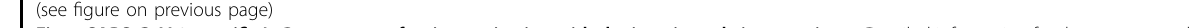
Fig. 1 SARS-CoV-2-speci fi c IgG responses after immunization with the inactivated virus vaccine. a Detailed information for the serum samples. b Sample collection after vaccination. Red dots represent volunteers who have four data points. c IgG pro fi les of vaccinated and convalescent sera against the SARS-CoV-2 proteome. FI, fl uorescence intensity, was shown in log scale, i.e., log 2 (FI) ranges from 0 to 14. d – m IgG responses to selected proteins. Antibody responses against SARS-CoV-2 proteins, the S protein ( d ), S1 subunit ( e ), RBD ( f ), N protein ( g ), N-Nter ( h ), N-Cter ( i ), NSP7 ( j ), NSP8 ( k ), NSP9 ( l ), and RdRp ( m ). Sera were collected from vaccinated volunteers at 21 and 28 days after the 2nd vaccine dose ( n = 27) and from convalescent patients ( n = 52). The P value was calculated by the two-sided Student ’ s t -test. * P < 0.05, ** P < 0.01, *** P < 0.005, **** P < 0.001, ns represents not signi fi